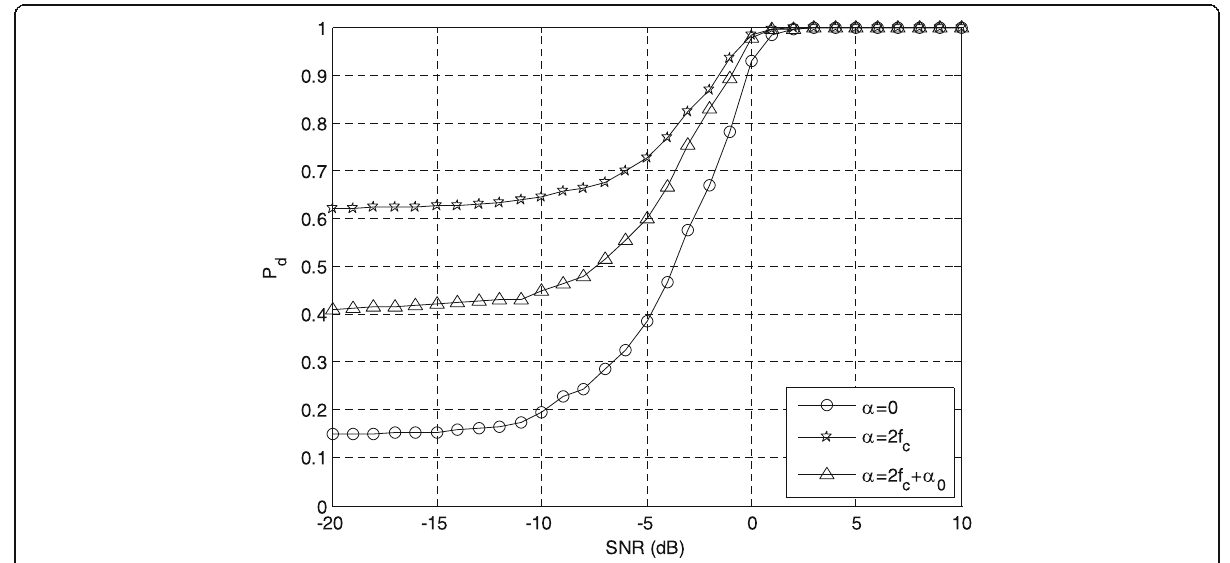
Fig. 4 Comparison of detection performance based on EGC method at different cyclic frequencies